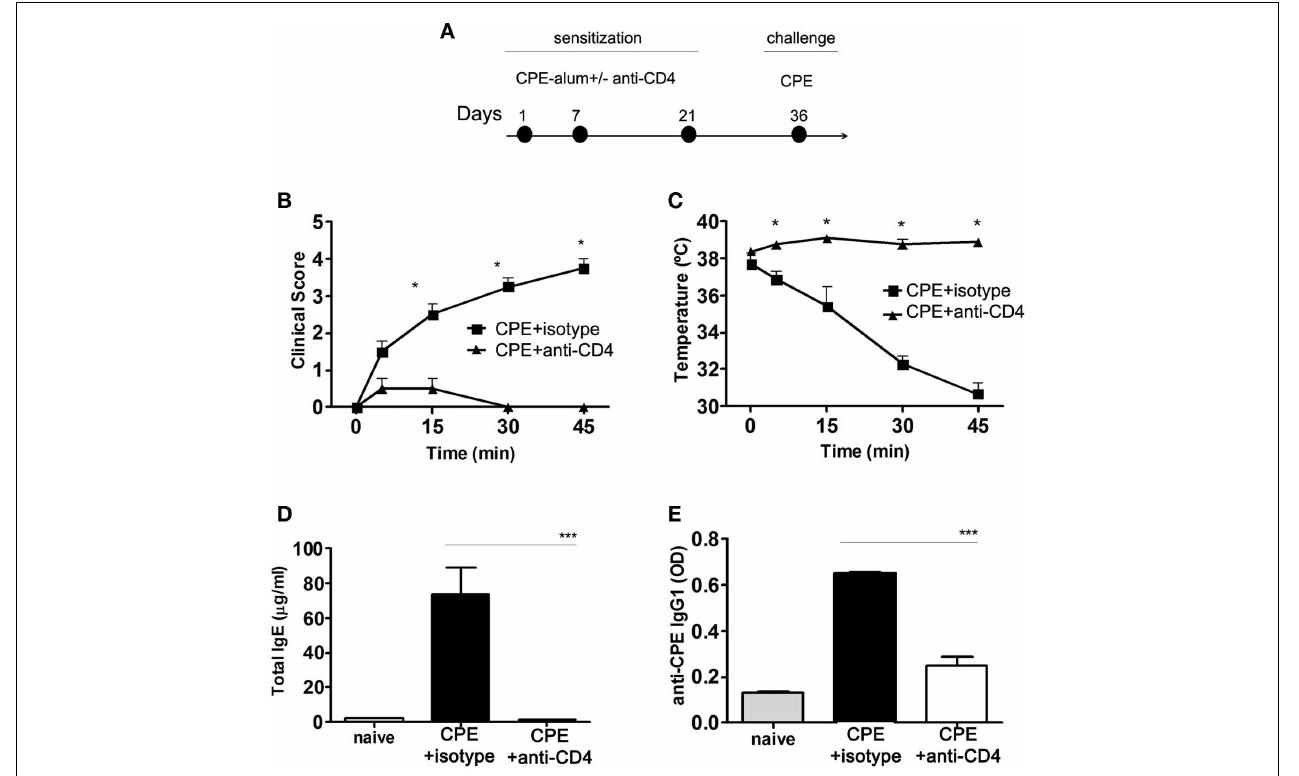
manifestations of disease ( n = 4, * P < 0.05). In addition, CPE-sensitized mice showed a sharp drop of body temperature ( n = 4, * P < 0.05). (D) Serum concentration of total IgE and (E) CPE-specific IgG1. Anti-CD4 treated mice maintained IgE levels at a concentration similar to naïve non-immunized mice, while mice treated with an isotype control significantly increased serum IgE and IgG1 ( n = 8, *** P < 0.001). Data (B–E) are representative of three independent